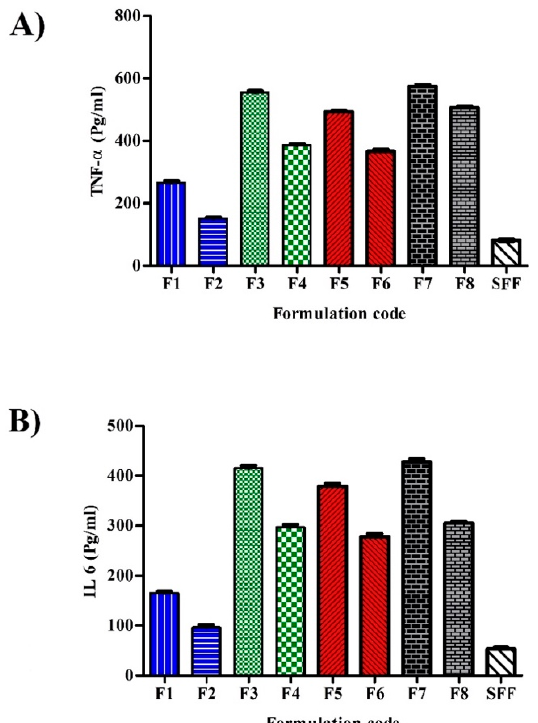
Figure 8. Secretions of ( A ) TNF- α and ( B ) IL-6 of SFF and different stabilizers containing formulations after incubation with 50 μ g/mL after 24 h ( n = 3).